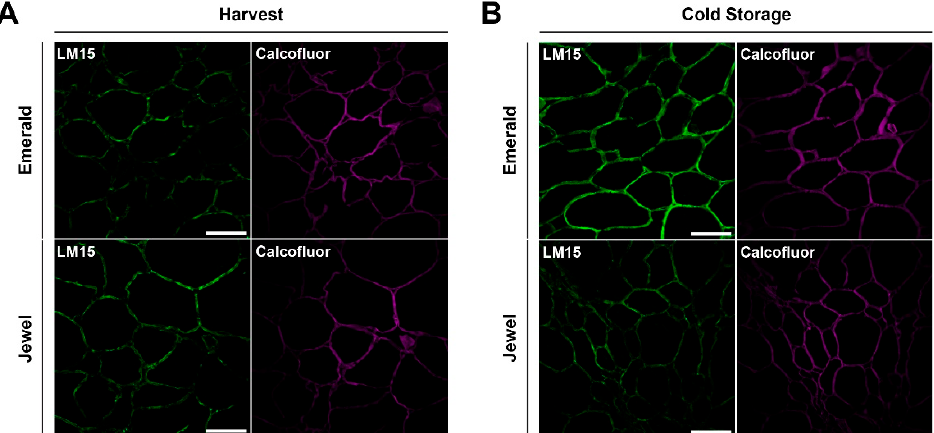
Figure 3. Immunolabeling of blueberry tissues from “Emerald” and “Jewel” cultivars at harvest and cold storage. Xyloglucan detection (green) at harvest ( A ) and cold storage ( B ). Counterstaining of cellulose (magenta). Bars = 100 µm (n = 3).